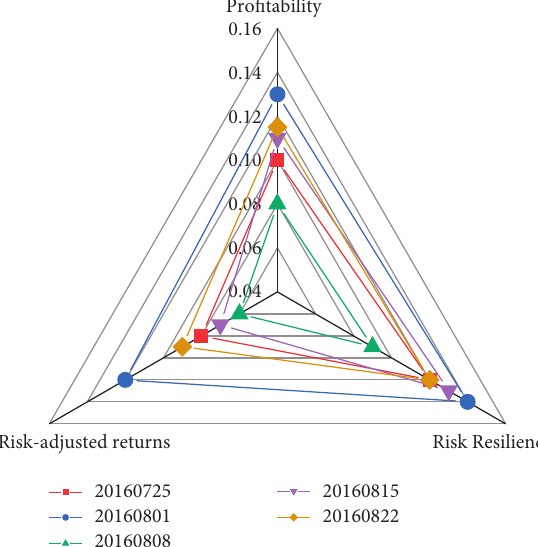
Figure 7: Evaluation of fund performance value at different